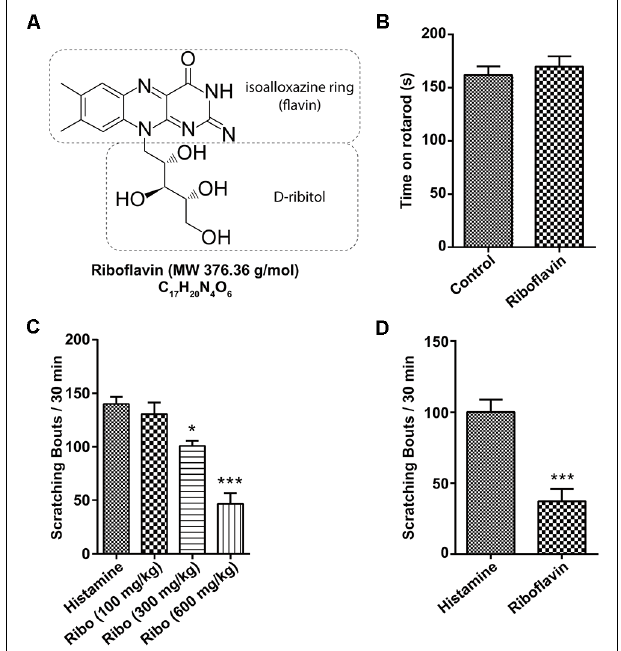
FIGURE 1 | Effect of riboflavin on itching caused by histamine. (A) Molecular structure of riboflavin. (B) Motor function assessed by fall latency on the rotarod test after the oral administration of vehicle or riboflavin (600 mg/kg, n = 3). Total scratching bouts during the first 30 min after (C) the oral administration of riboflavin (each 100, 300, and 600 mg/kg, n = 5) or (D) the intradermal injection of riboflavin (1 µ M, n = 5, * p < 0.05, *** p < 0.001). Ribo,